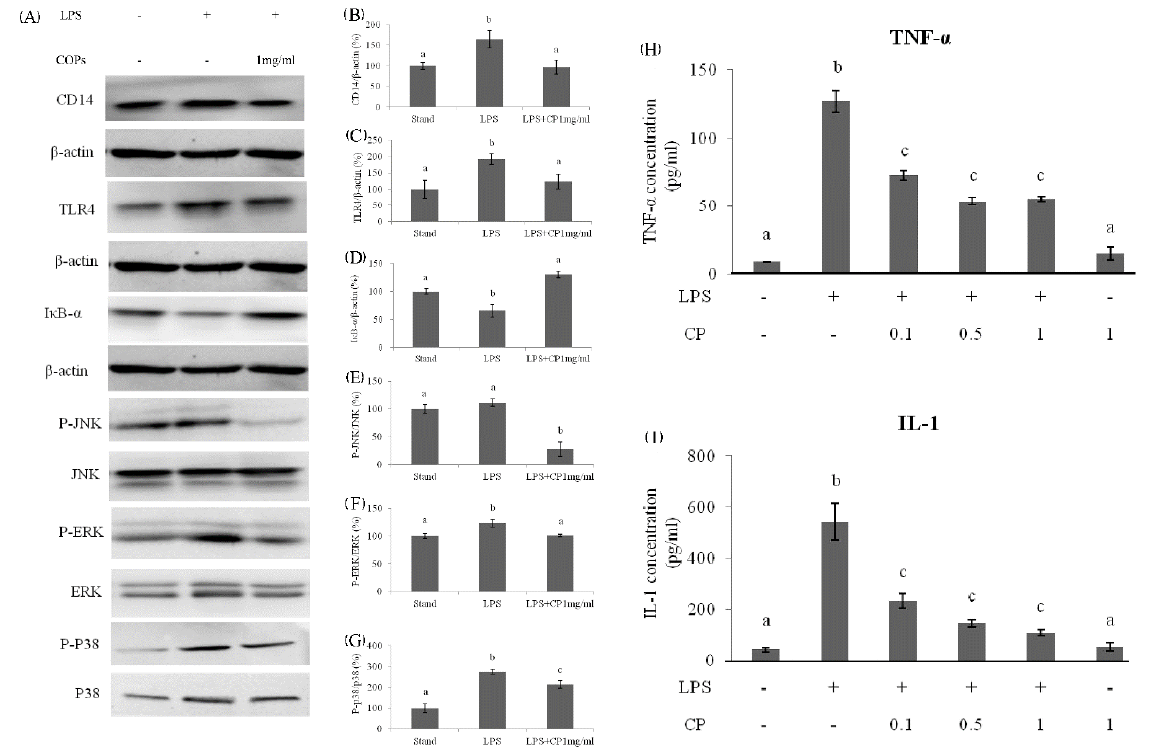
Figure 7. The effects of protein expression at 1 h after LPS administration in Kupffer cells: ( A ) Bands of proteins. The values of CD14 ( B ) and TLR4 ( C ) were normalized by the value of the total protein. ( D ) The effects of CPs on IkB- α degradation at 1 h after LPS administration in Kupffer cells. The expression levels of phosphorylated and total JNK, ERK, and p-38 protein were detected by western blotting. The value of JNK ( E ), ERK ( F ), and p-38 ( G ) were normalized by the value of the total protein. The effects of CPs on the TNF- α ( H ) and IL-1 ( I ) expression level in supernatants of KCs at 12 h after LPS treatment. Different letters represented the significant difference at p < 0.05.